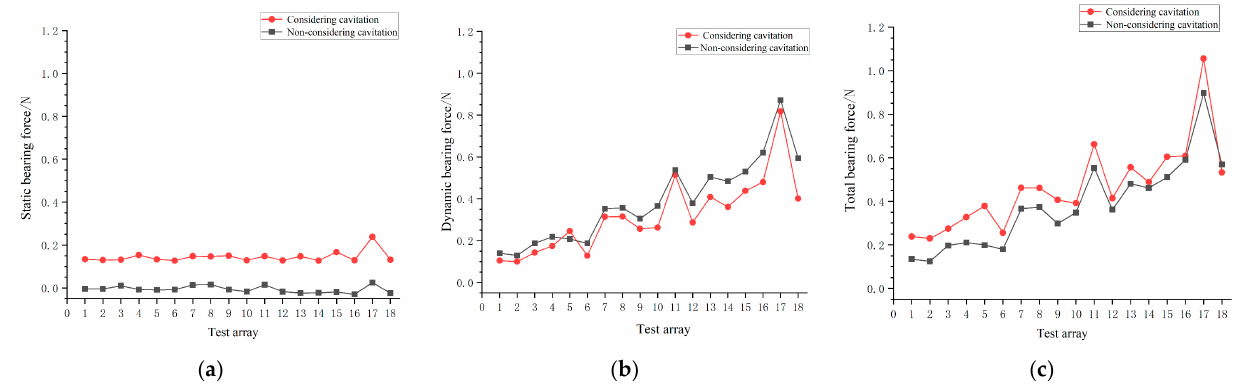
Figure 13. Line diagram of bearing force with and without cavitation effect. ( a ) Line diagram of static pressure; ( b ) Line diagram of dynamic pressure; ( c ) Line diagram of total pressure.